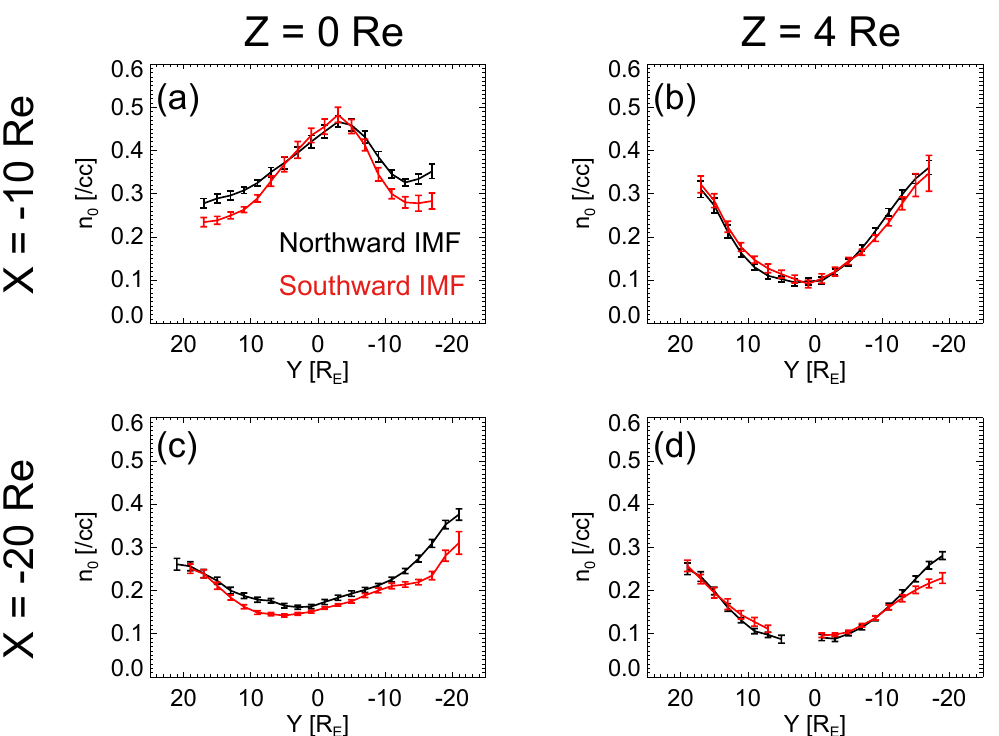
Fig. 3. Y profiles of plasma number density n 0 at X = − 10 and − 20 R E for the northward and southward IMF conditions. Error bar is twice of standard